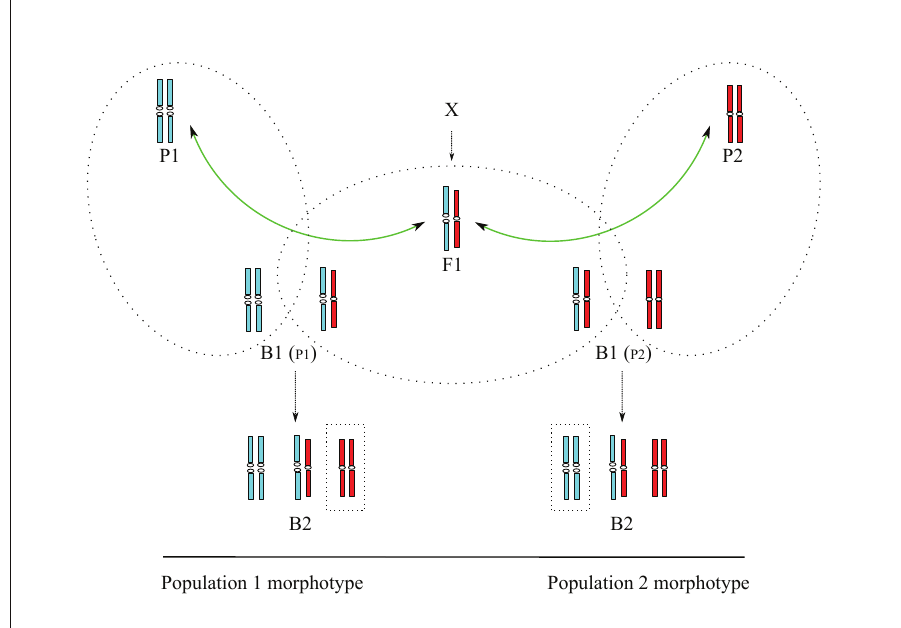
Figure 2. Segregation of karyotypes and morphological traits in the hybrid zone between two chromo- some races. Positions of karyotypes reflect their morphological state: individuals of pure parental type (P1 and P2) with the most pronounced morphological differences occupy rightmost and leftmost positions, F1 – intermediate between P1 and P2 and the first-generation backcrosses – intermediate between F1 and respective parents (B1 and B1 ). The second-generation backcrosses (B2) contain karyotypes that do P1 P2 not correspond to the expected morphotypes (marked with squared frames). Round frames mark karyo- typically indistinguishable parents, F1 and B1 (see text for